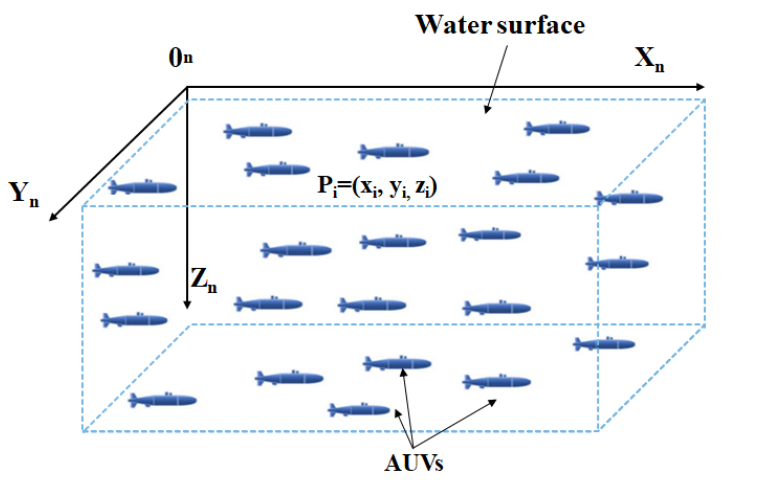
Figure 2. AUV system